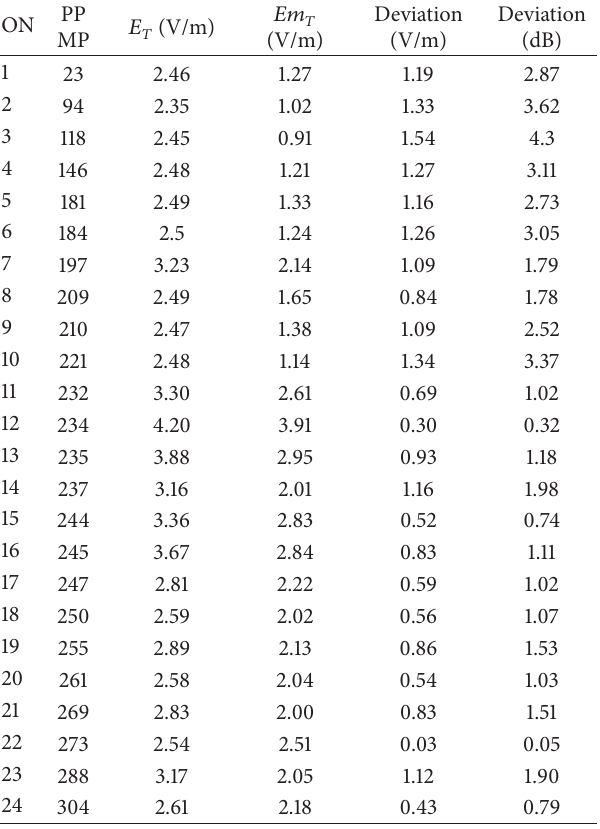
Figure 8: Predicted and measured values of total electric field